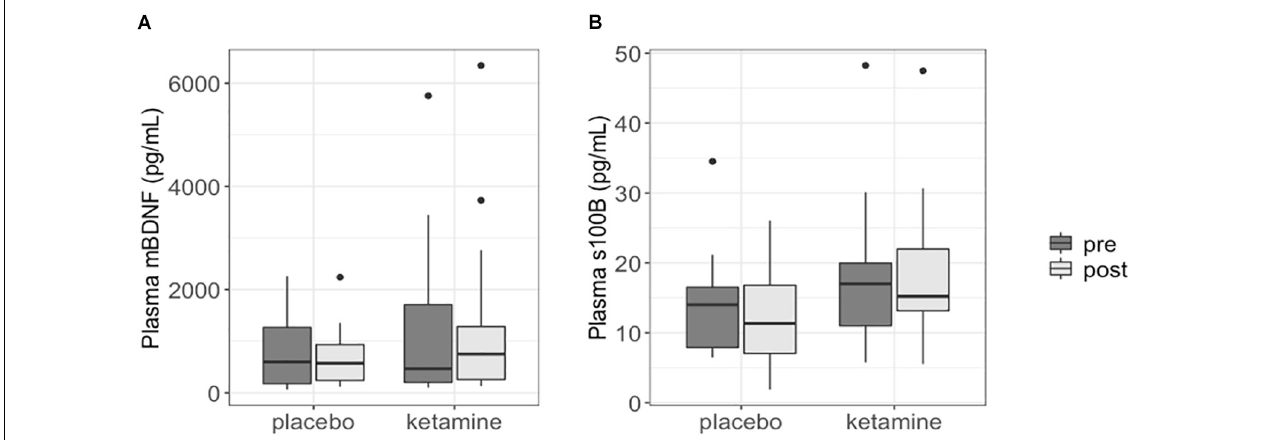
FIGURE 1 | Boxplots showing plasma mBDNF (A) and S100B (B) levels in patients with SSRI-resistant major depressive disorder. Each box represents the interquartile range of the data, with median shown as horizontal line. Vertical lines represent the minimum and maximum values within 1.5 times the interquartile range distance from the 1st and 3rd quartile, respectively. Outliers are represented as single dots.